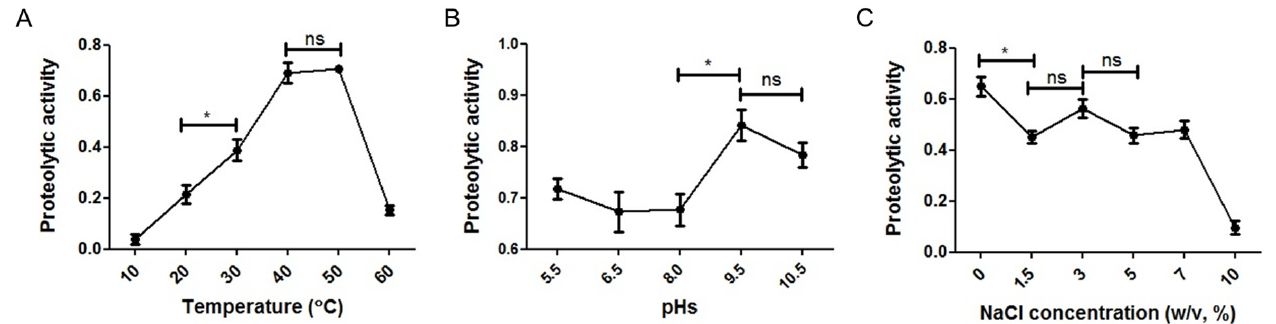
Figure 4. Influence of temperature, pH, and NaCl concentration on the proteolytic activity of SK1-1. Optimum temperature, pH, and NaCl concentration for proteolytic activity were determined with azocasein as substrate. All the experiments were performed in triplicate. ‘*’ and ‘ns’ indicate ‘significantly different ( p < 0.05)’ and ‘not significantly different ( p > 0.05)’, respectively, when two data sets were compared. Examination of optimum conditions of ( A ) temperature, ( B ) pH, and ( C ) NaCl concentration.